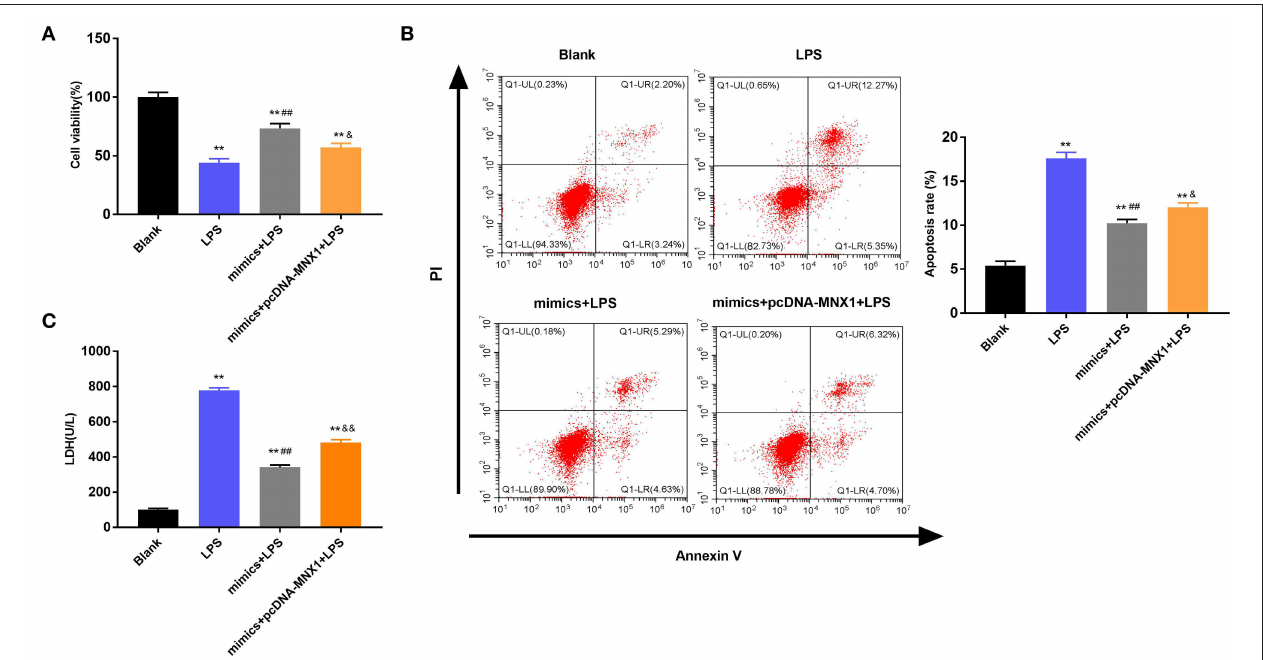
FIGURE 6 | MNX1 modulated the influences of miR-141-3p in IEC-6 cell viability and apoptosis. After LPS irritation and the correlative vectors transfection, (A) the vitality of IEC-6 cells was assessed via MTT assay; (B) apoptotic degree of IEC-6 cells was evaluated via flow cytometry assay; (C) cell death was tested via LDH activity analysis. ** P < 0.01 in comparison with the Blank group; ## P < 0.01 in comparison with the LPS group; & P < 0.05, && P < 0.01 in comparison with mimics +